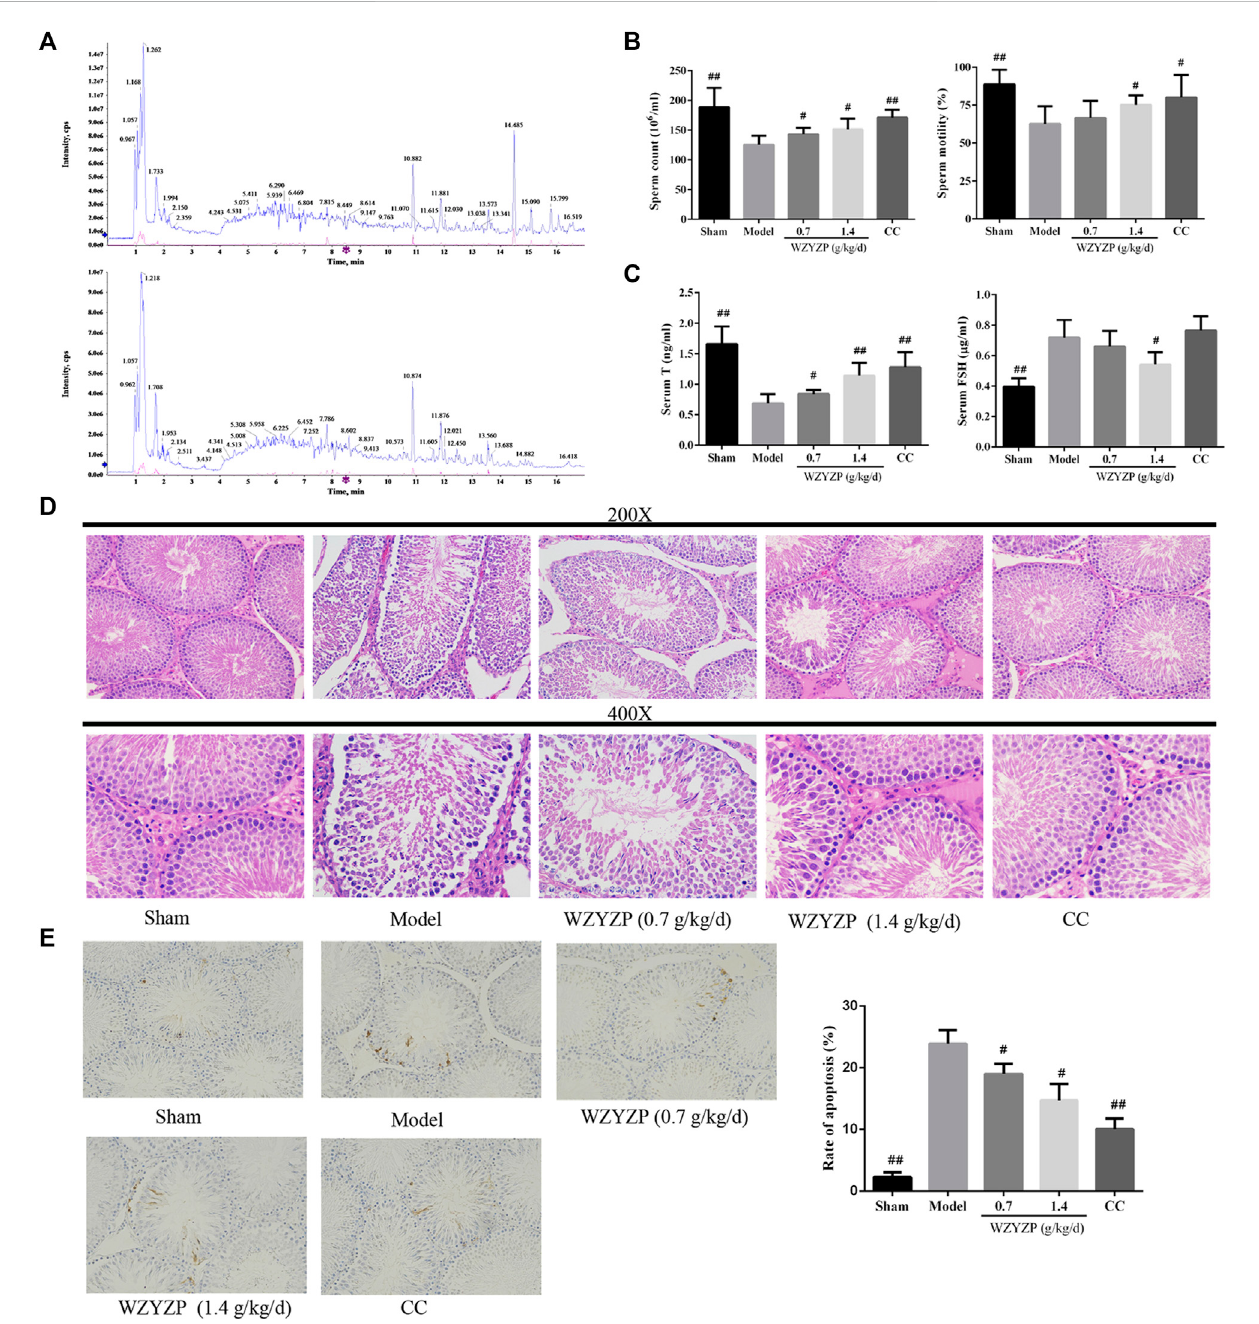
FIGURE 4 Compounds identi fi cation and the effect of the WZYZP on the experimental spermatogenesis disorder model rats. (A) The phytochemical compositions identi fi cation in the WZYZP by UHPLC-Q-TOF/MS in the positive ion mode and negative ion mode. (B) Effect of the WZYZP on sperm counts and motility. (C) EffectofWZYZP onserumhormonelevels ofT,FSHlevels weredetectedwith anELISAassay. (D) HEstainingtoevaluate theeffect oftheWZYZPonrattestes histological changes. Above, magni fi cation ×200, 400. (E) TUNEL staining for the evaluation of cell apoptosis. Above, magni fi cation ×200. # p < .05 vs. Model group, ## p < .01 vs. Model